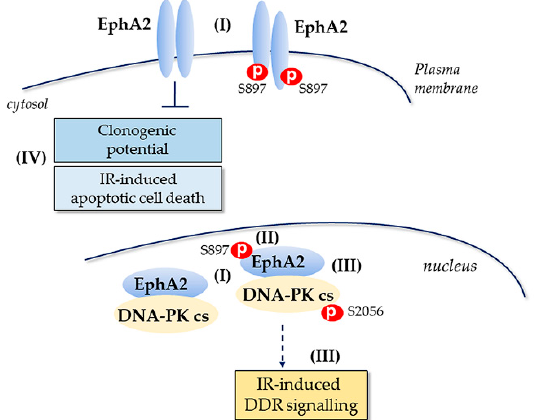
Figure 6. EphA2 interacts with DNA-PKcs in cell nucleus and influences IR-induced cellular response of NSCLC cells. Our data indicate that both total and EphA2 S897 are present in the cell nucleus prior to and post IR alongside localization in plasma membrane and cytosol (I). We observed a transient increase in EphA2 S897 early upon IR treatment and also found increased EphA2 total protein expression (II). We report on a novel interaction between EphA2 and DNA-PK cs which may influence DDR signaling with the molecular details to be further studied (III) as well as on IR-induced clonogenic survival and cell death via the apoptotic route (IV). Thus, our findings indicate that in certain NSCLC cells, EphA2 alongside its effect on signaling events taking place at the plasma membrane/cytosol may also impact on IR-induced DDR signaling and highlight further a possible therapeutic potential of EphA2 for some NSCLC cases.